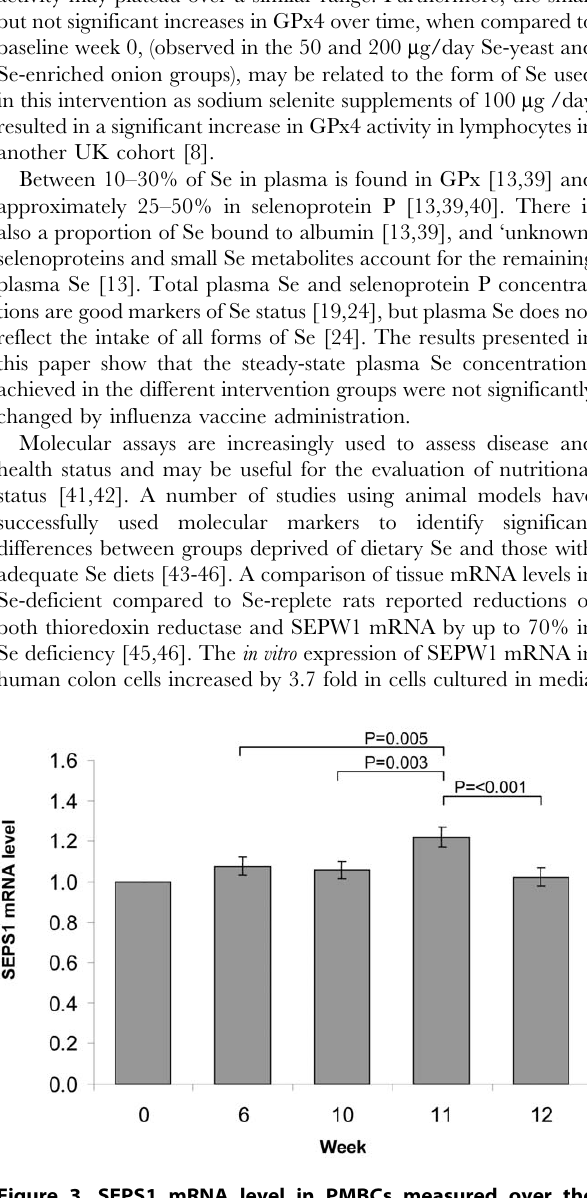
missing time course sample data for some of the target genes. For the SEPS1 gene expression data set: placebo group n=20 at all time points; 50 m g/day group n=14 at wks 0, 6 and 12 (n=13 at wks 10, 11); 100 m g/ day group n=19 at wks 0, 6, 10 (n=18 at wks 11, 12); 200 m g/day group indicated on the figure.